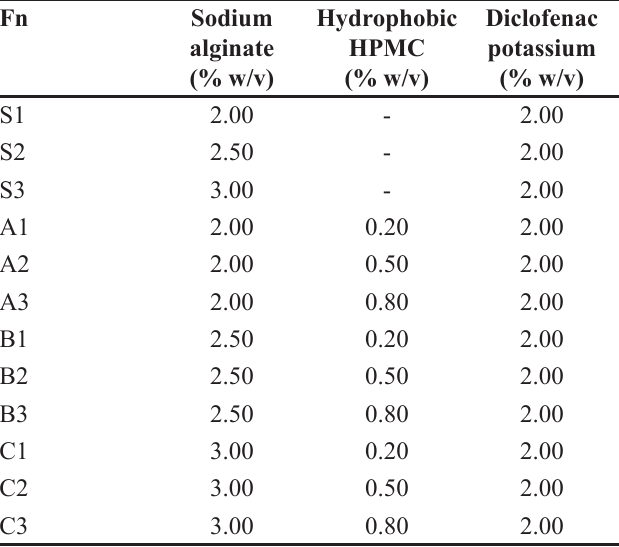
TABLE I - Composition of different formulations used for preparation of diclofenac potassium microspheres